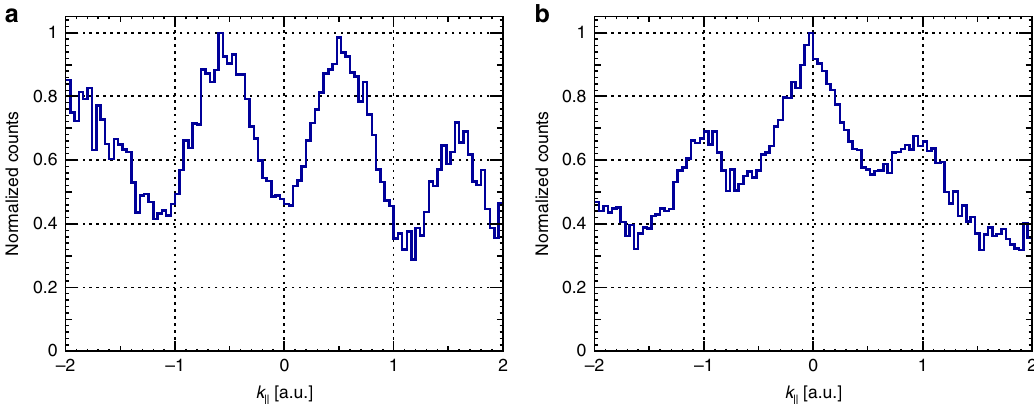
Fig. 3 Photoelectron momentum distributions of Ne 2 for linearly polarized light. Normalized photoelectron momentum distributions projected to the molecular axis for the direct ( a ) and indirect ( b ) dissociation pathways in case of linearly polarized light. The spectra were generated by selecting only the events, where the dimer axis lies within ±15 to the polarization direction of the laser fi eld. In addition, the ion momenta were limited to 4.5 – 16 a.u. and 39 – 45 a.u for the direct and indirect dissociation, respectively. Original spectra were divided by the corresponding spectrum of the monomer in order to remove the ionization weighting. k ║ is the electron momentum component parallel to the dimer